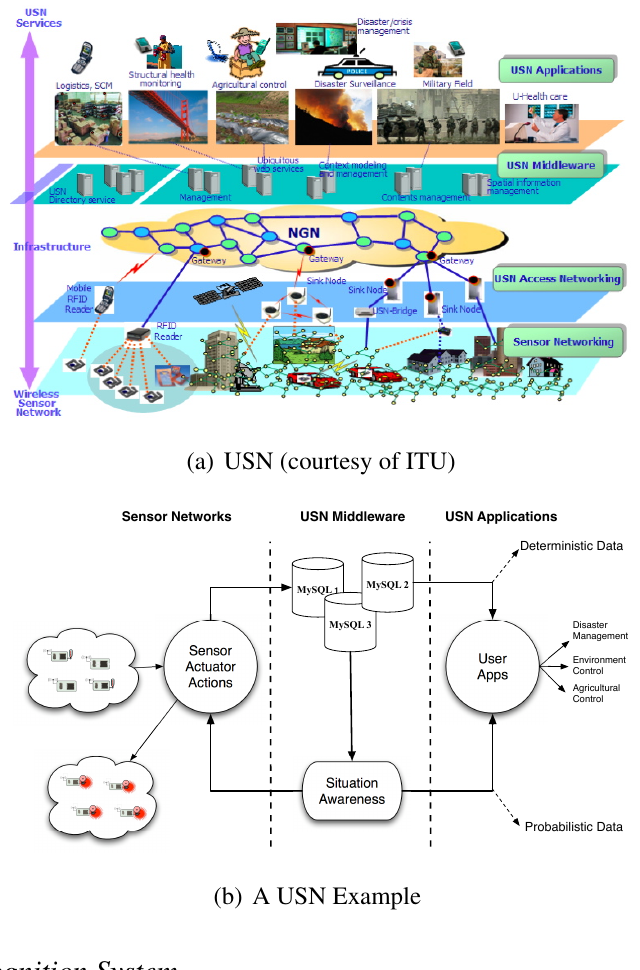
Figure 1. Ubiquitous Sensor Network. (a) USN Illustrated from [1]. (b) Situation Recognition System.